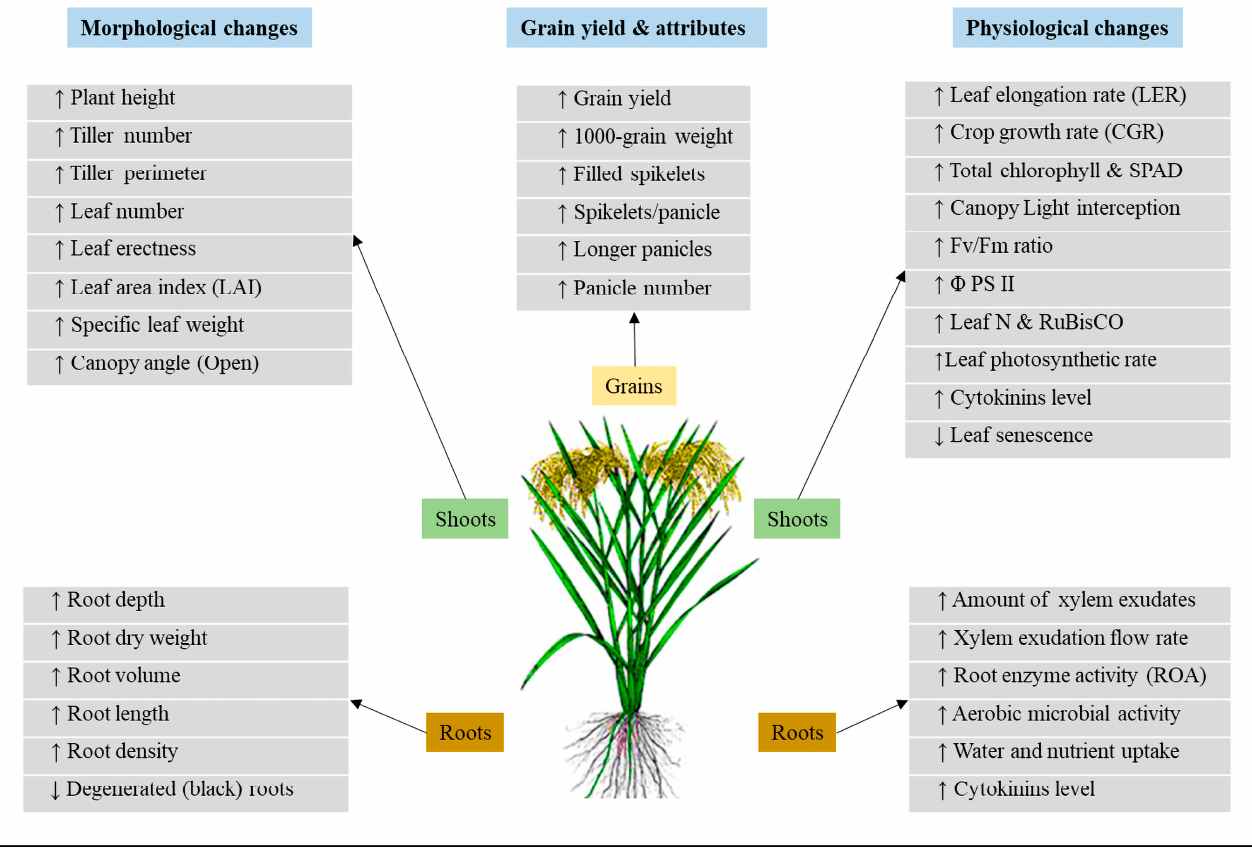
Figure 5. Influence of the SRI method on morphological, physiological changes, and yield in rice. Sources: [4,10,18].